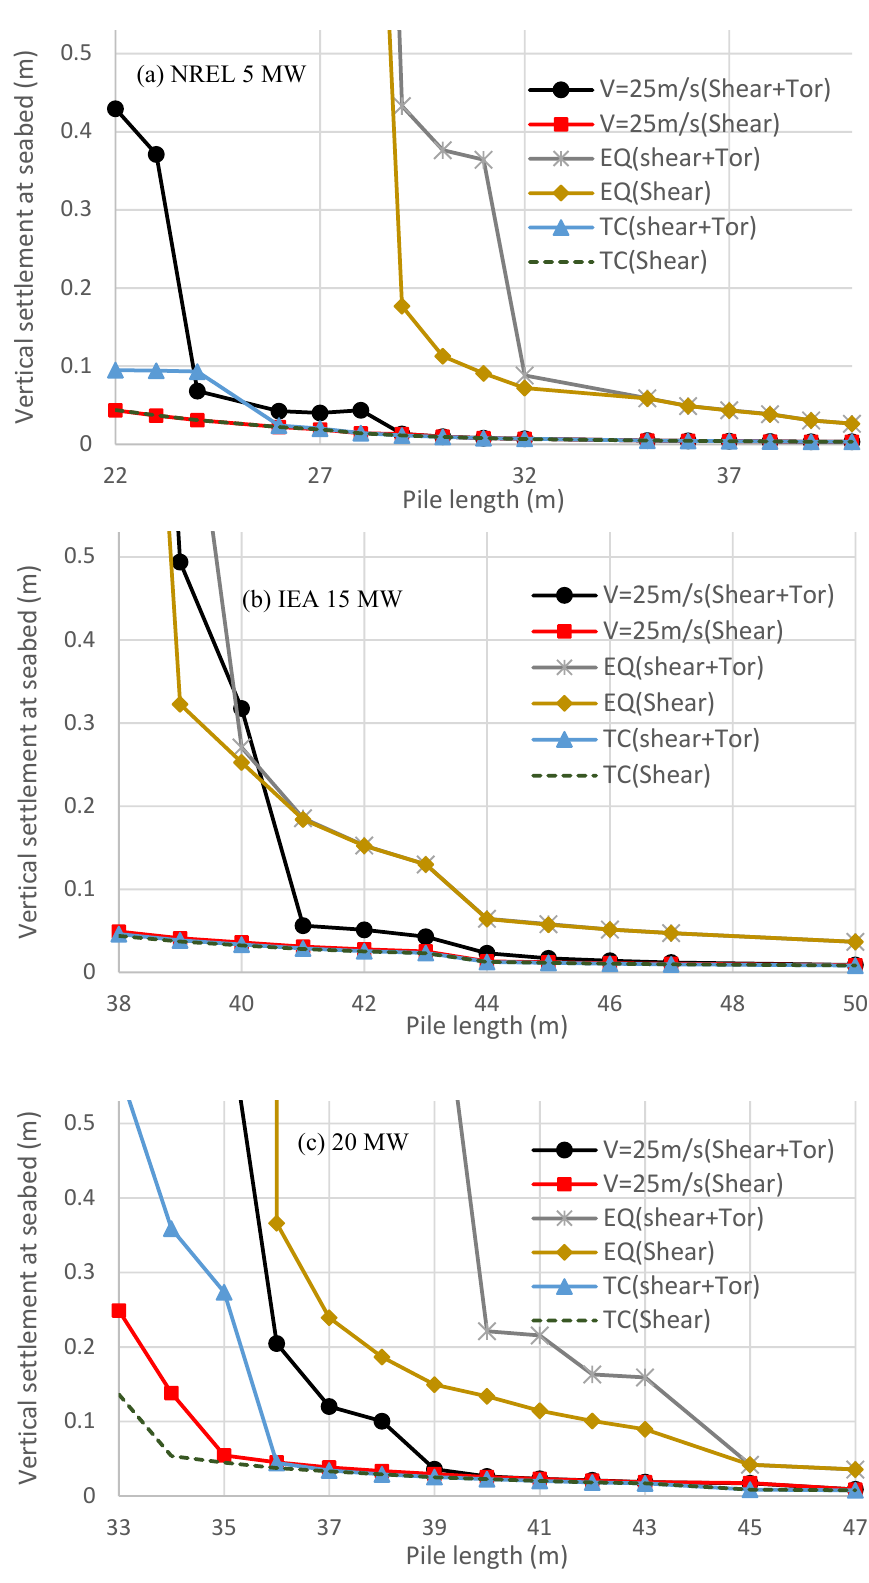
Figure 8. The changes in the pile vertical displacement in the sea bed with the used pile length for the 5, 15, and 20 MW cases under loads of DLC 1.1 ( V hub = 25 m/s), DLC 1.8 (0.32 g earthquake and V hub = 11.4 m/s), and DLC I.2 (Tropical cyclone V hub = 72 m/s). ( a ) NREL 5 MW; ( b ) IEA 15 MW; ( c ) 20 MW.